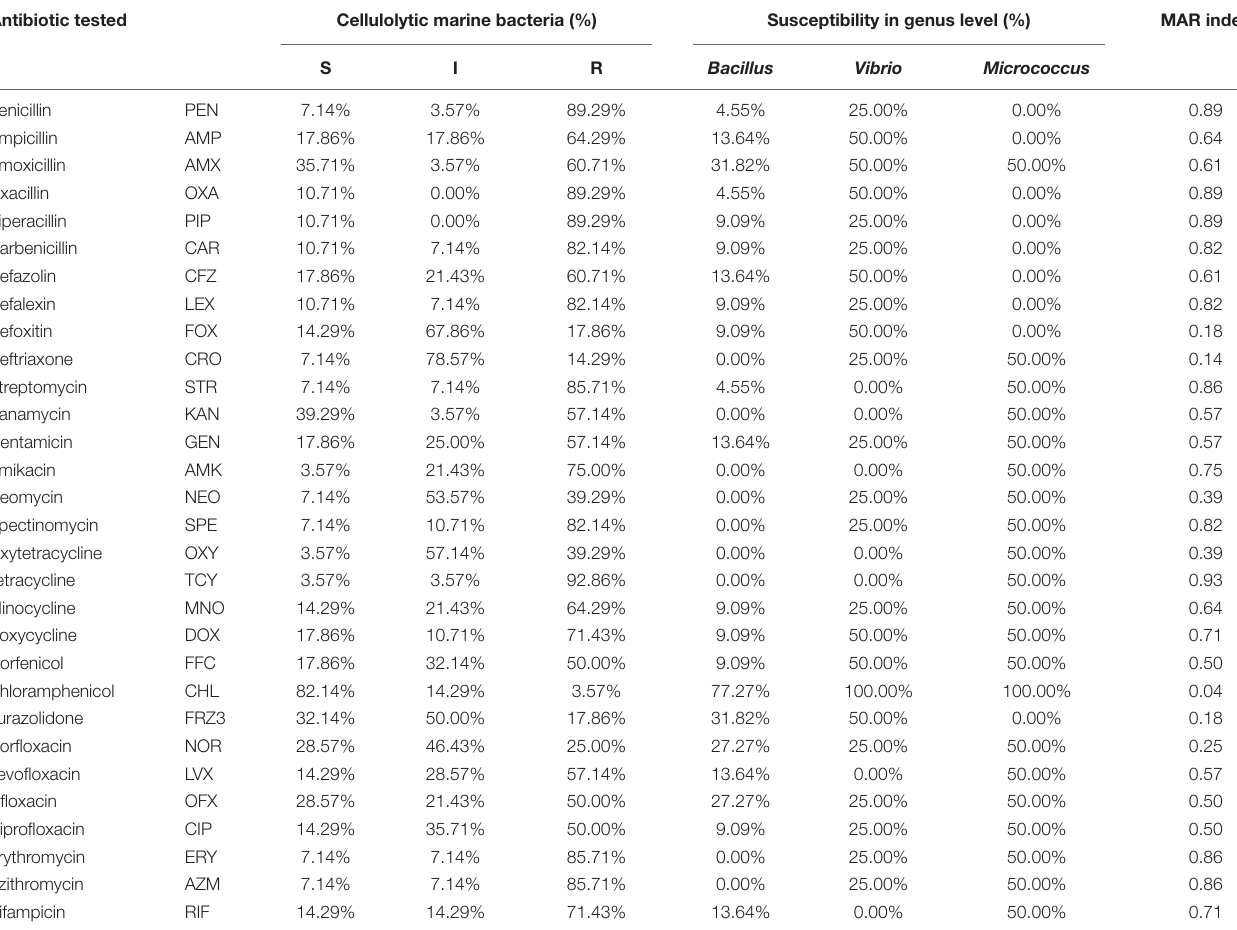
TABLE 3 | Resistance patterns of 28 cellulase-producing marine bacteria according to antimicrobial susceptibility test using 30 kinds of antibiotics. Antibiotic tested Cellulolytic marine bacteria (%) Susceptibility in genus level